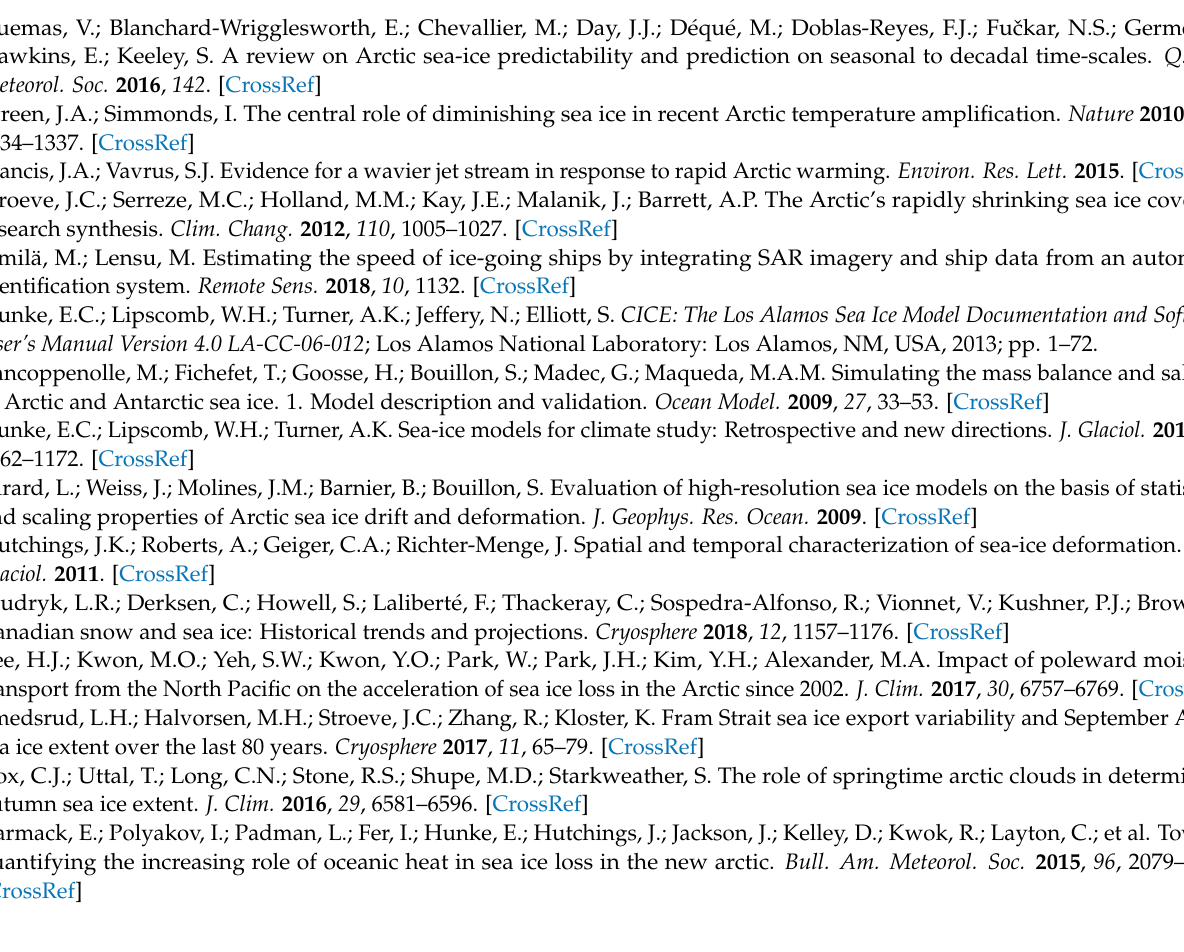
Figure A2. RMSE comparison of different input sequence lengths. The light blue, light green, blue, and magenta line represent the RMSE of ConvLSTM at the input time series of 1, 2, 3, and 4 days, respectively. The red line represents the RMSE of CNNs. By comparing the models with different input sequence lengths, this study verified that for ConvLSTM a longer input time sequence did not result in better prediction. By comparing the SSIM and RMSE, the daily SIC model prediction was best when the input time sequence was two days.